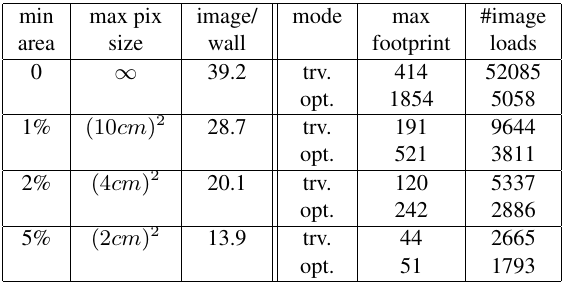
Table 2: Influence of geometric criteria on visibility graph den- sity, and comparison of memory footprint and loading times be- tween trivial (trv.) and optimized (opt.) processing.